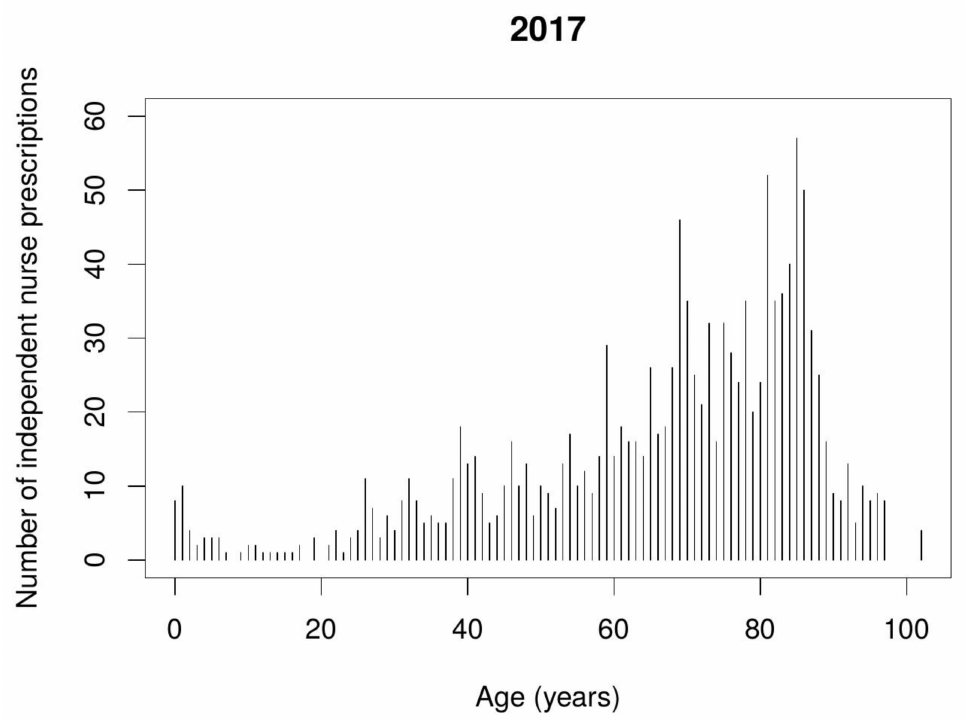
Figure 2. Number of nurse independent prescriptions depending on the patient’s age during the second year of